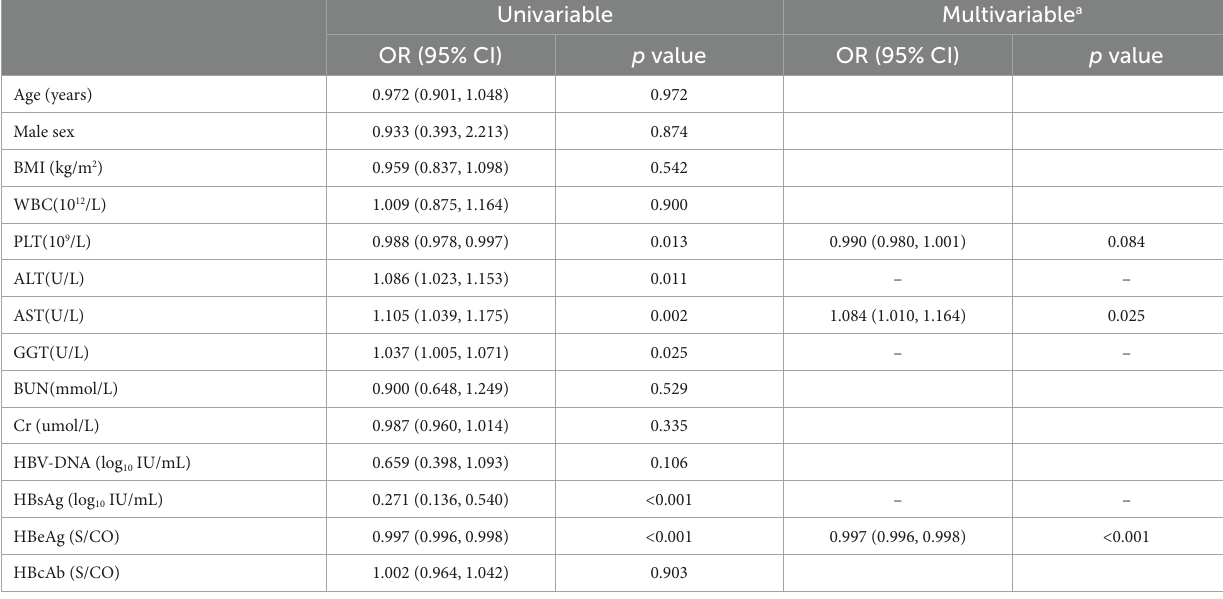
TABLE 2 Univariable and multivariable analysis in the training